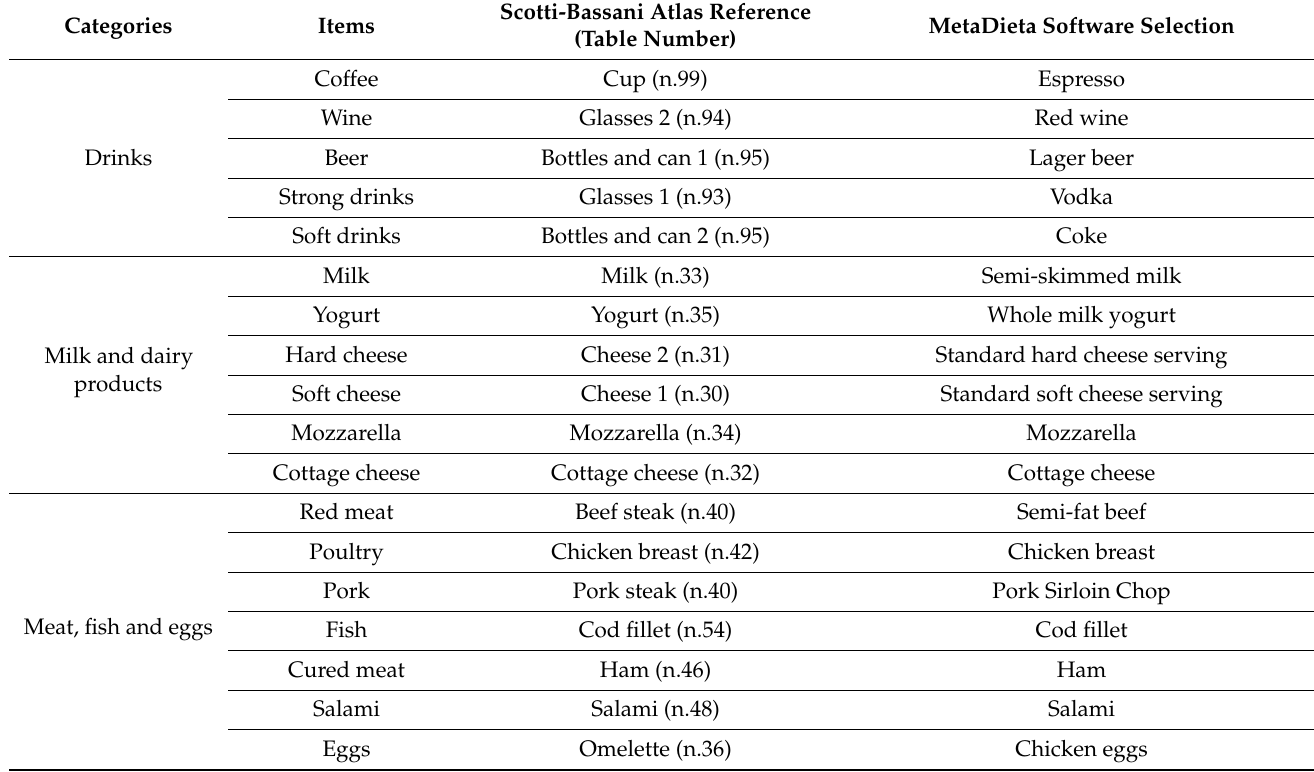
Table A1. Procedure used to calculate energy and nutrients content from